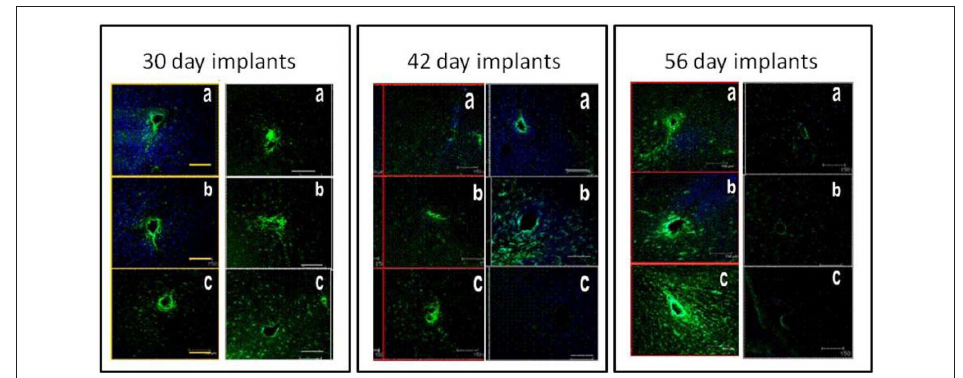
experimental animals where the microelectrode was moved at days 14 and 28 after implantation show significantly reduced GFAP expression (indicating reduced reactive astrocytic response) compared to the corresponding control brain sections. The tissue sections are perpendicular to the direction of the microelectrode shank. GRAP expression is shown in green and MAP2 expression is shown in